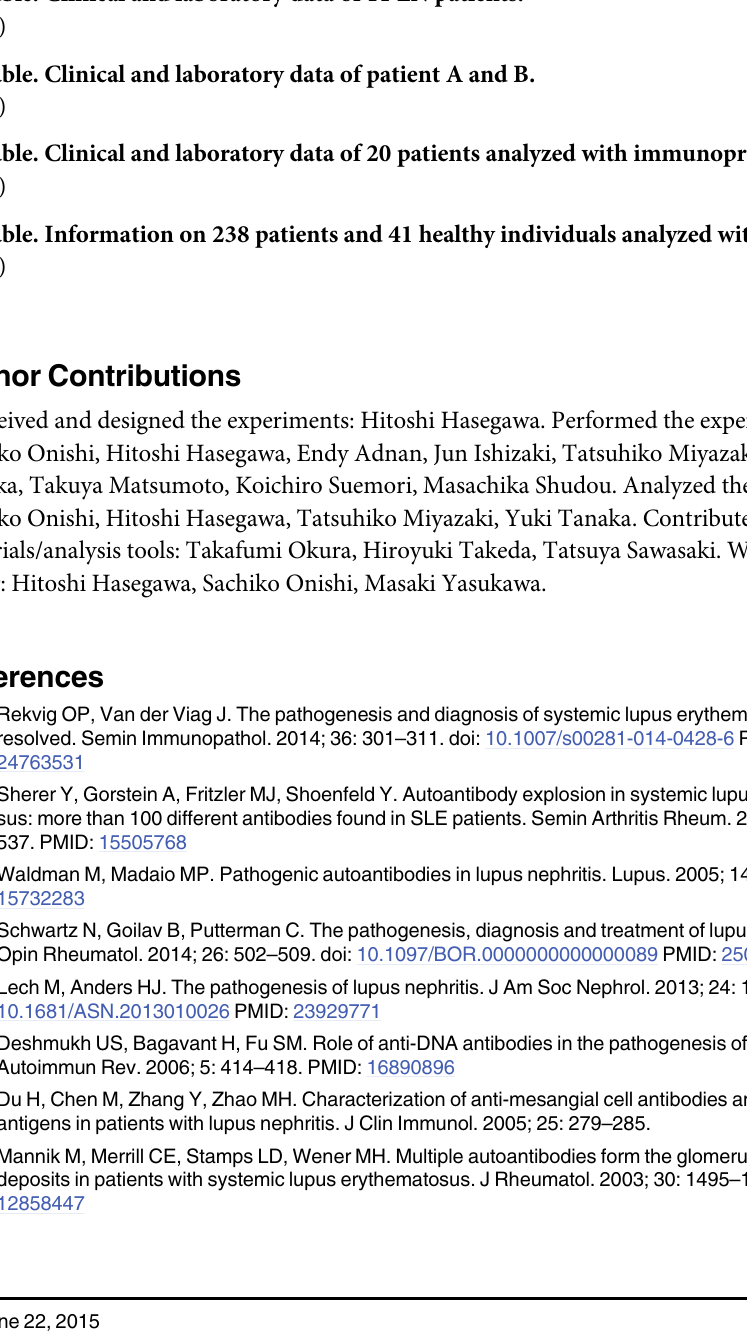
S9 Fig. Immunofluorescence of TNP1 and IgG in the liver of TNP1-injected mice. S10 Fig. Expressions of TNP1 and RRP8 in the human tissues. The expressions of TNP1 and RRP8 were analyzed with PCR using MTC cDNA panels. S1 Table. Clinical and laboratory data of 11 LN patients. S2 Table. Clinical and laboratory data of patient A and B. S3 Table. Clinical and laboratory data of 20 patients analyzed with immunoprecipitation. S4 Table. Information on 238 patients and 41 healthy individuals analyzed with